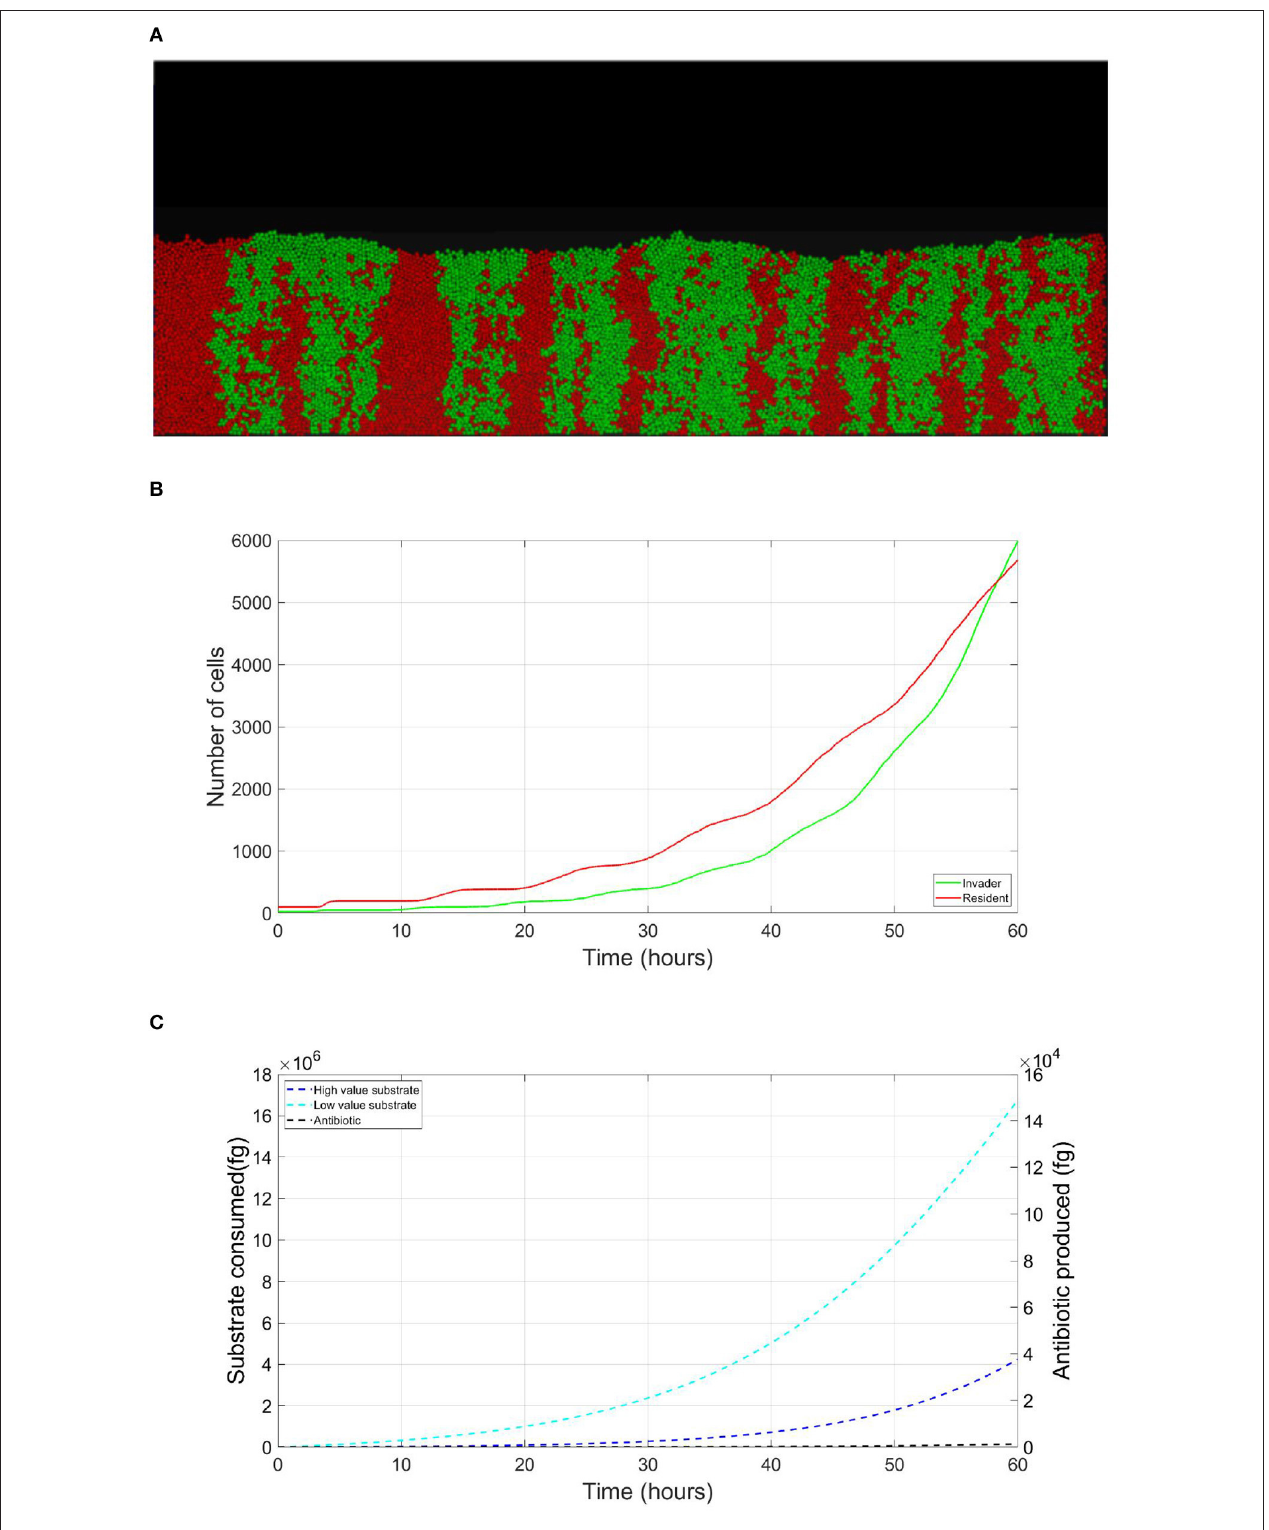
FIGURE 7 | Niche segregation, signaling scenario: when the resident species responds to an antibiotic signal from the invader species by switching to its metabolism to a low value nutrient, the further release of the antibiotic is avoided, to the benefit of both species. (A) A snapshot of the competition between the invader species (green) vs. the resident species (red), by the end of the simulation. (B) The evolution of the population of an antibiotic producing invader and a resident species, when the resident species respond to signaling by specializing in the low value nutrient. (C) The evolution of the total consumption of the two nutrients as well as the production of the antibiotic by the invader